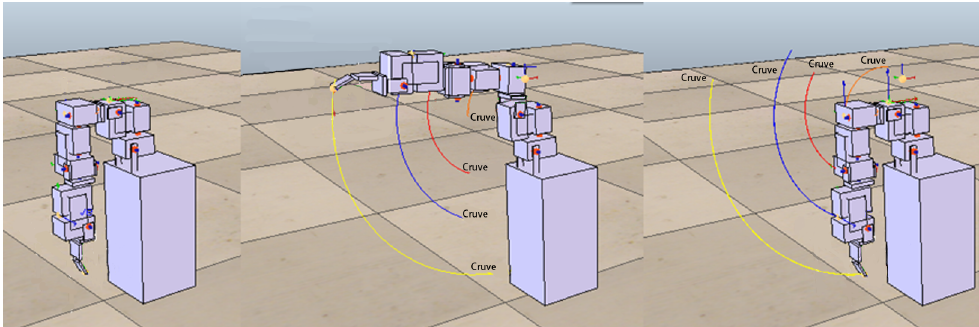
Figure 6. The motion trajectory of the side-lifting action. Each colored line represents the movement trajectory of the motor bearing. In this study, only the fingertip trajectory (in yellow color) of the robotic arm was used.